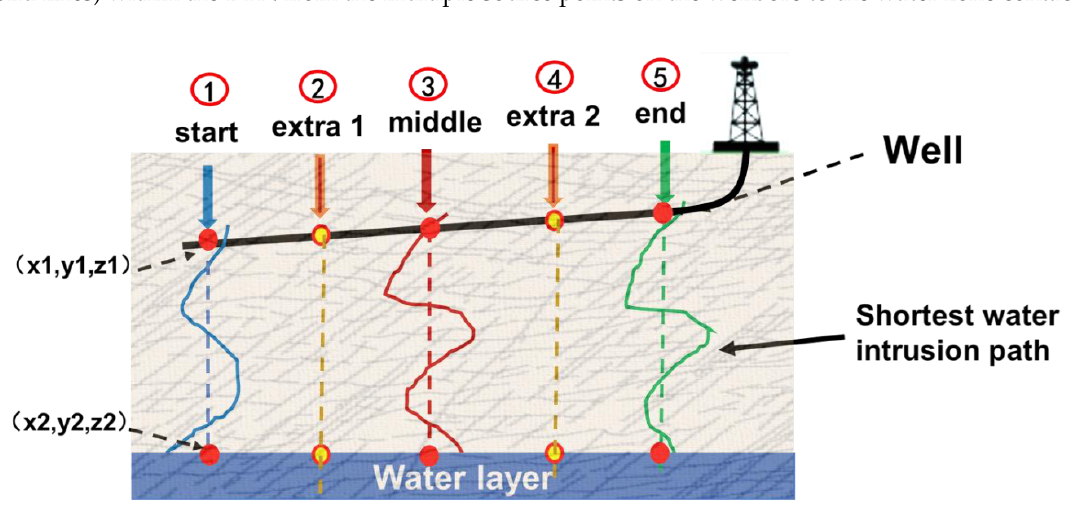
Figure 4. Schematic portrait of how connected fractured paths (solid lines) from the wellbore to the water zone contact network are intended to be identified within a DFN based on the shortest distance (stripped lines) in order to characterize water intrusion.